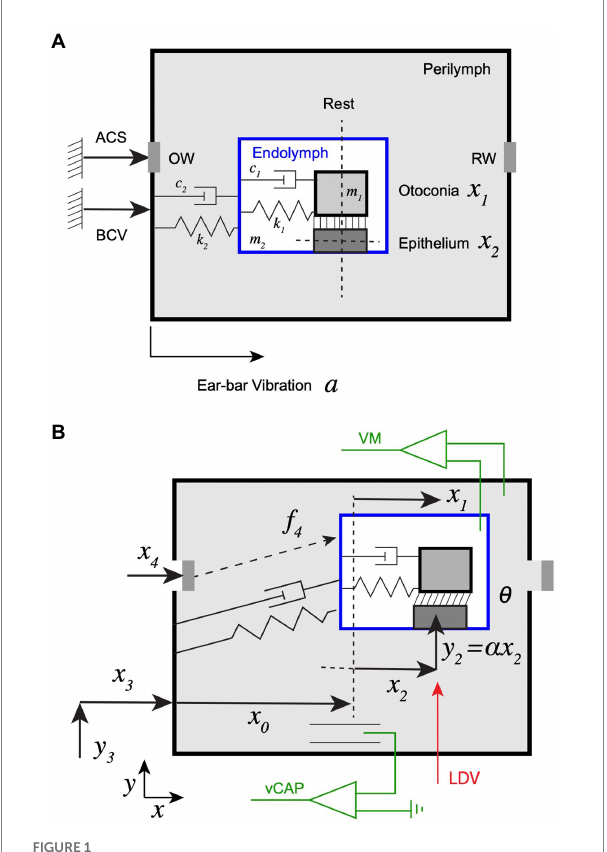
FIGURE 1 Experimental set up and schematic of the mechanical